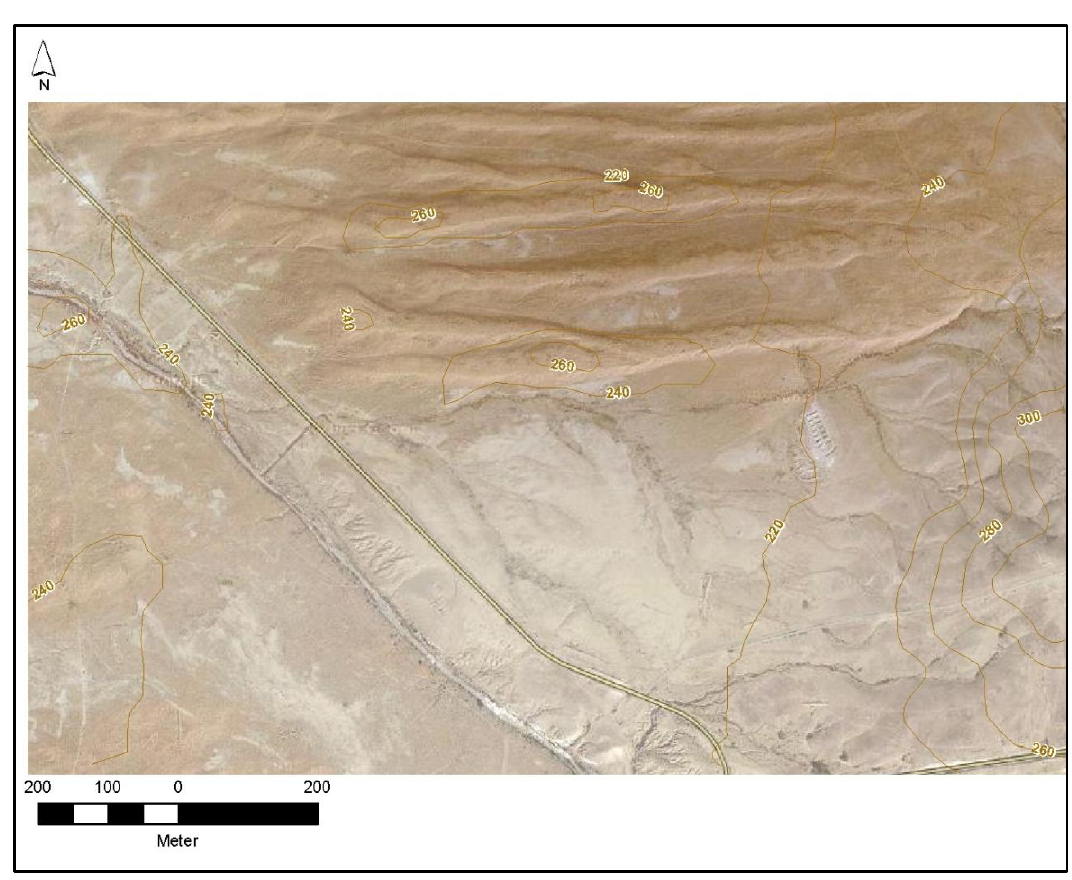
Figure 10. Topographic map (from 1979) presented on aerial digital photo (national orthophoto 2002) with a resolution of 2